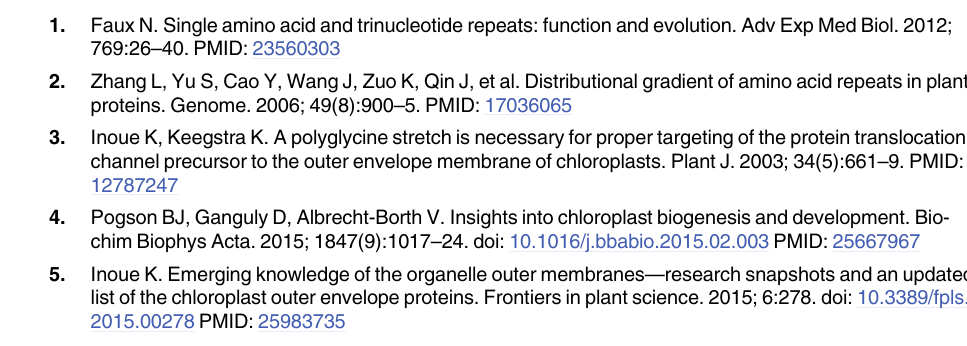
S8 Fig. Preparation of